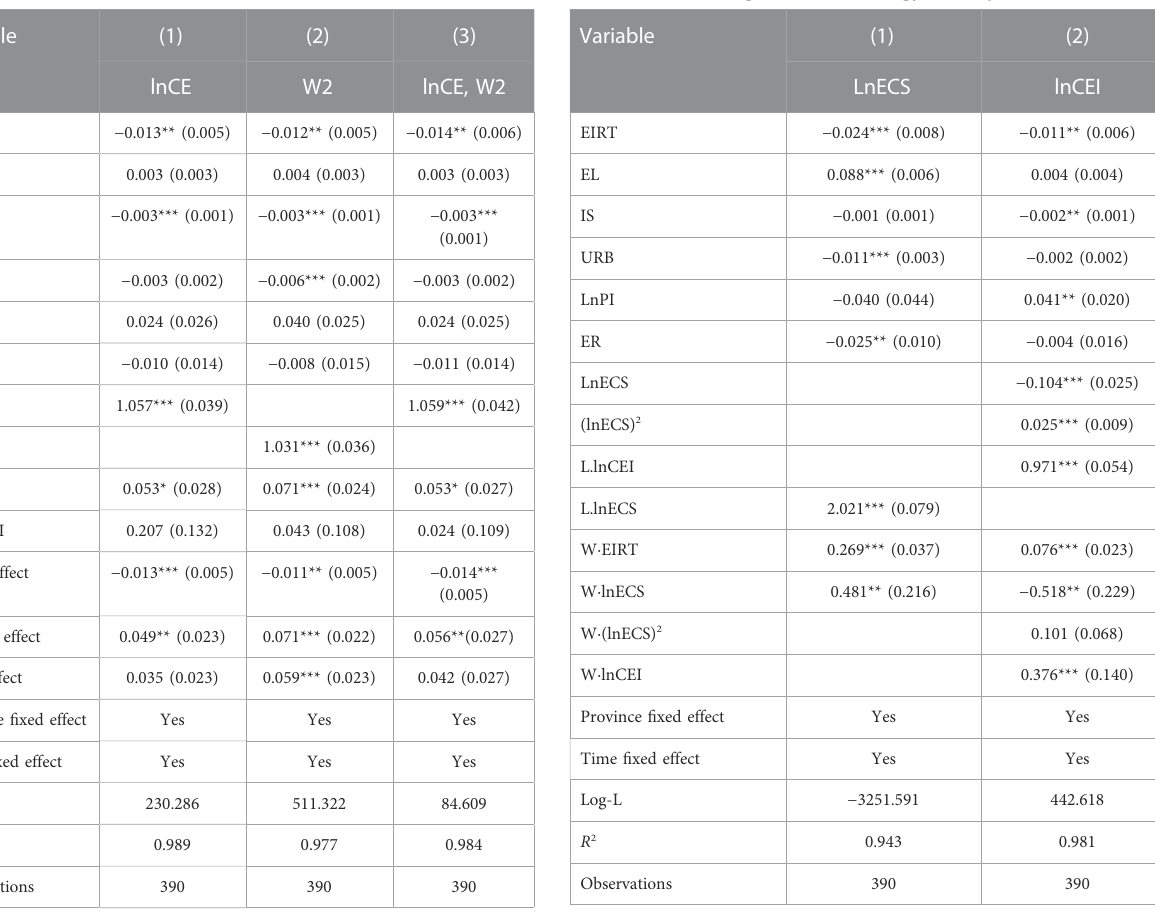
TABLE 5 Robustness test results. TABLE 6 The mediating effect test of energy consumption